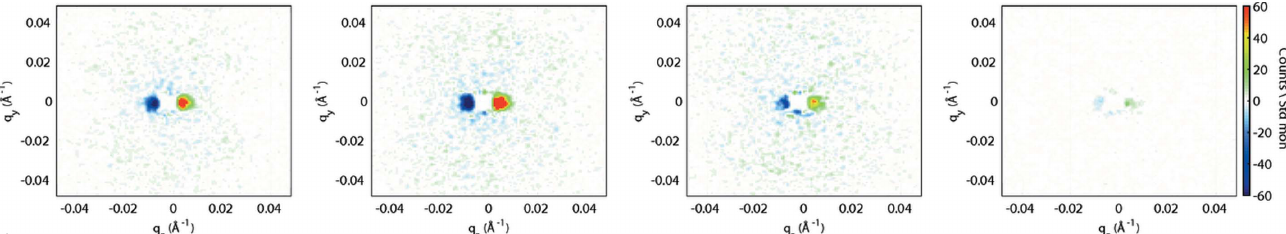
Figure 5 Sample-thickness dependence of the polarized SANS contrast signal I + (cid:3) I (cid:3) . Sample thickness from left to right: 7, 19, 26 and 35 sheets of Vitroperm (Fe 73 Si 16 B 7 Nb 3 Cu 1